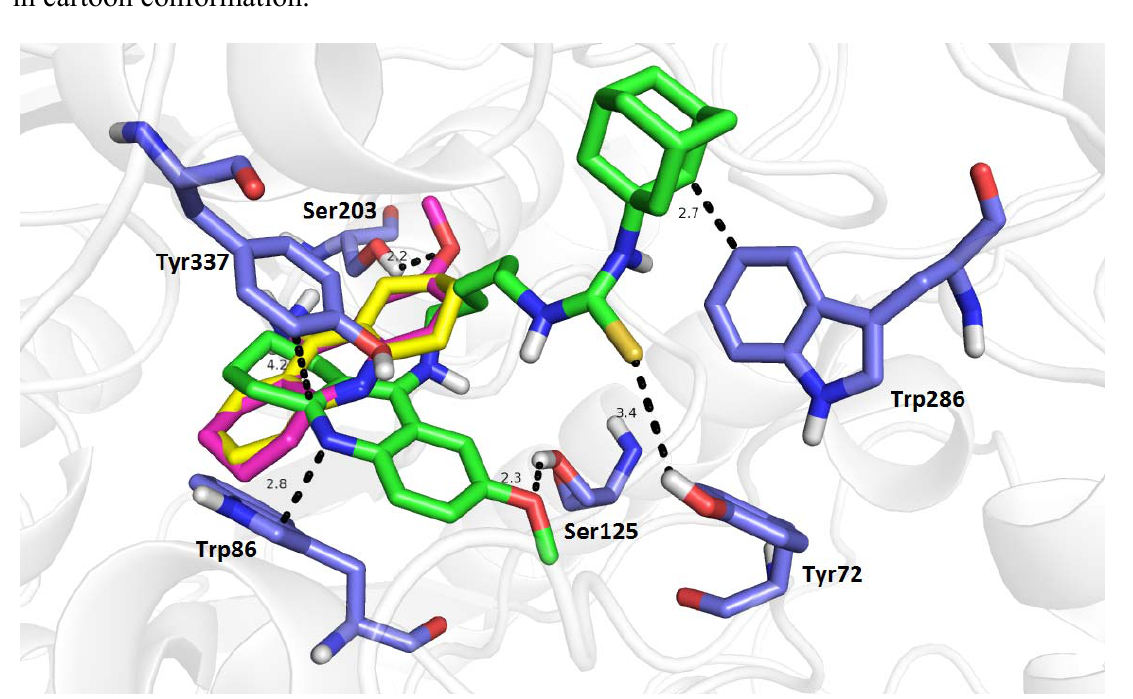
Figure 5. Putative binding mode of 14 (green), THA (yellow) and 7-MEOTA (magenta). Some important amino acid residues (blue) are shown, the rest of hAChE is superimposed in cartoon